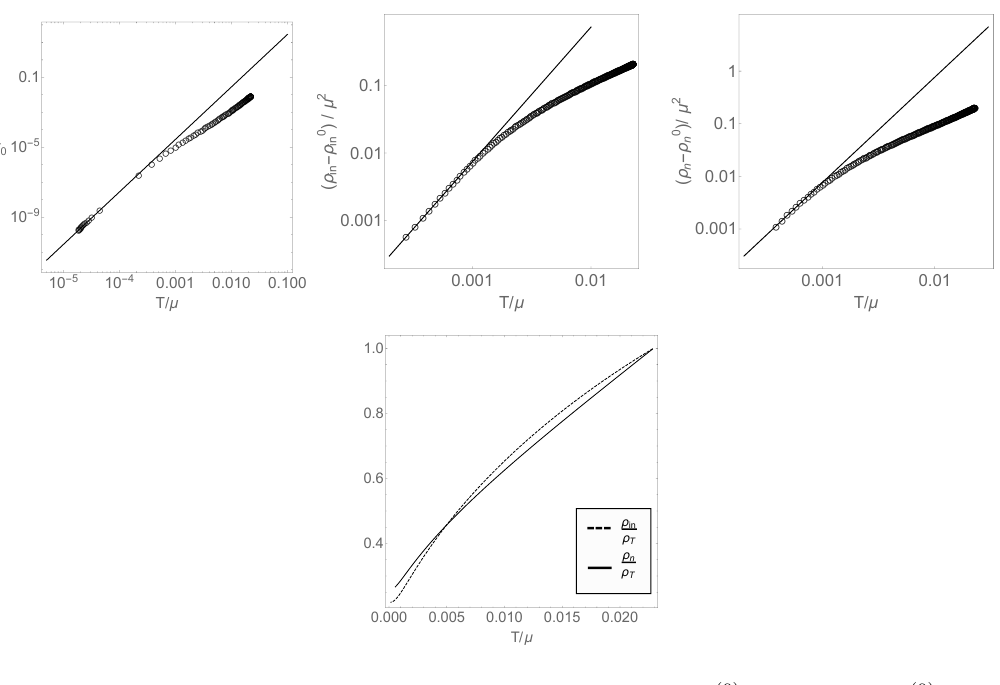
Figure 5 . a = 1( z → ∞ , θ → −∞ , z/θ = − 1) : σ 0 ∼ # T 3 , ρ in ∼ ρ (0)